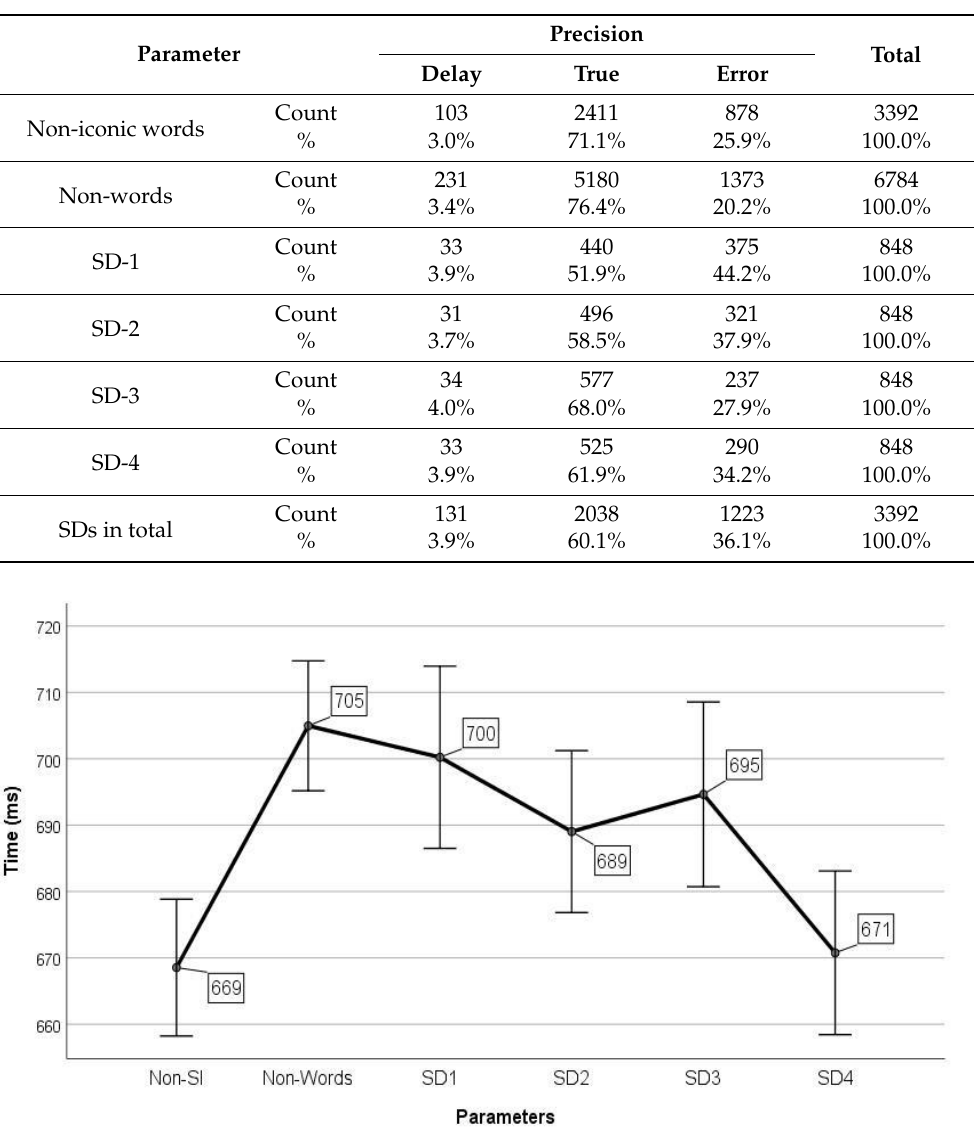
Table 5. Mean recognition time (in ms) and standard deviation for different stimuli types.